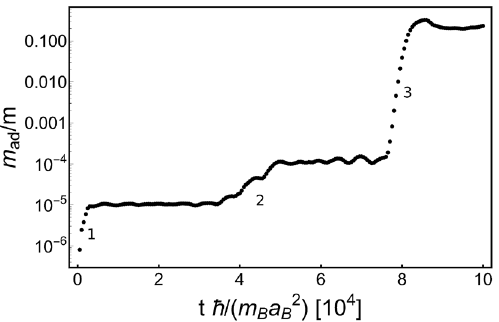
m wd )—the WD ≡ 2 4 (cid:31) in units of m B a B /